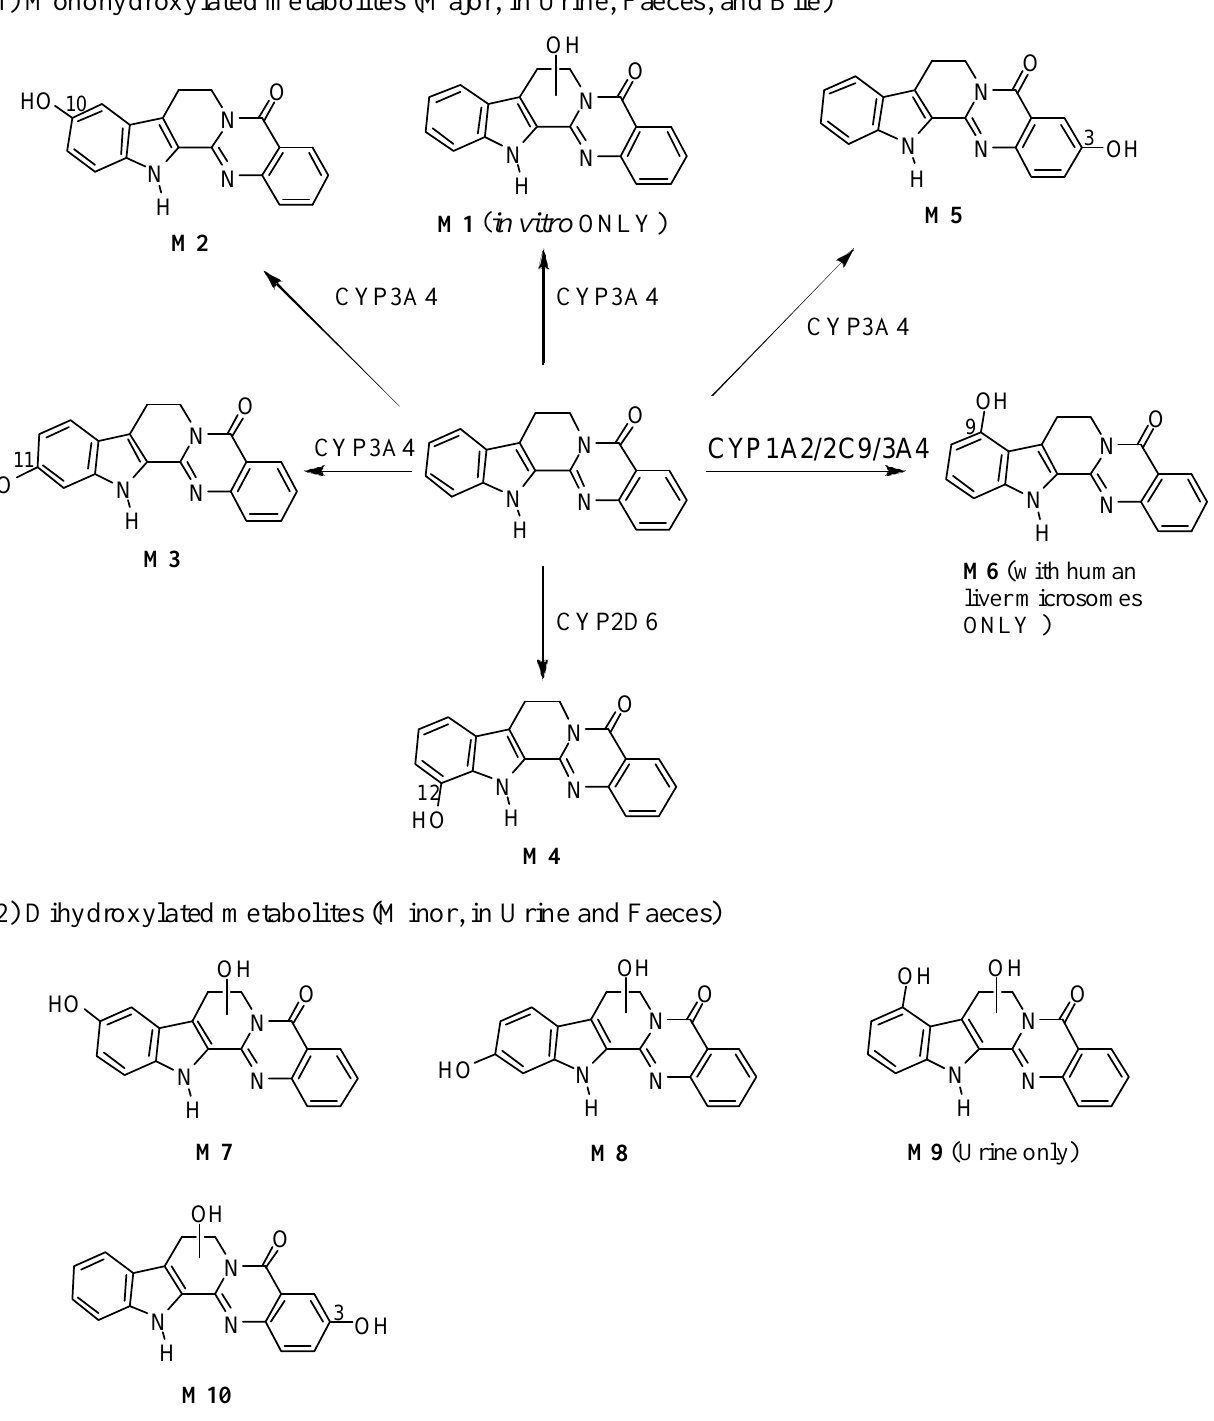
Figure 2 . Metabolites of